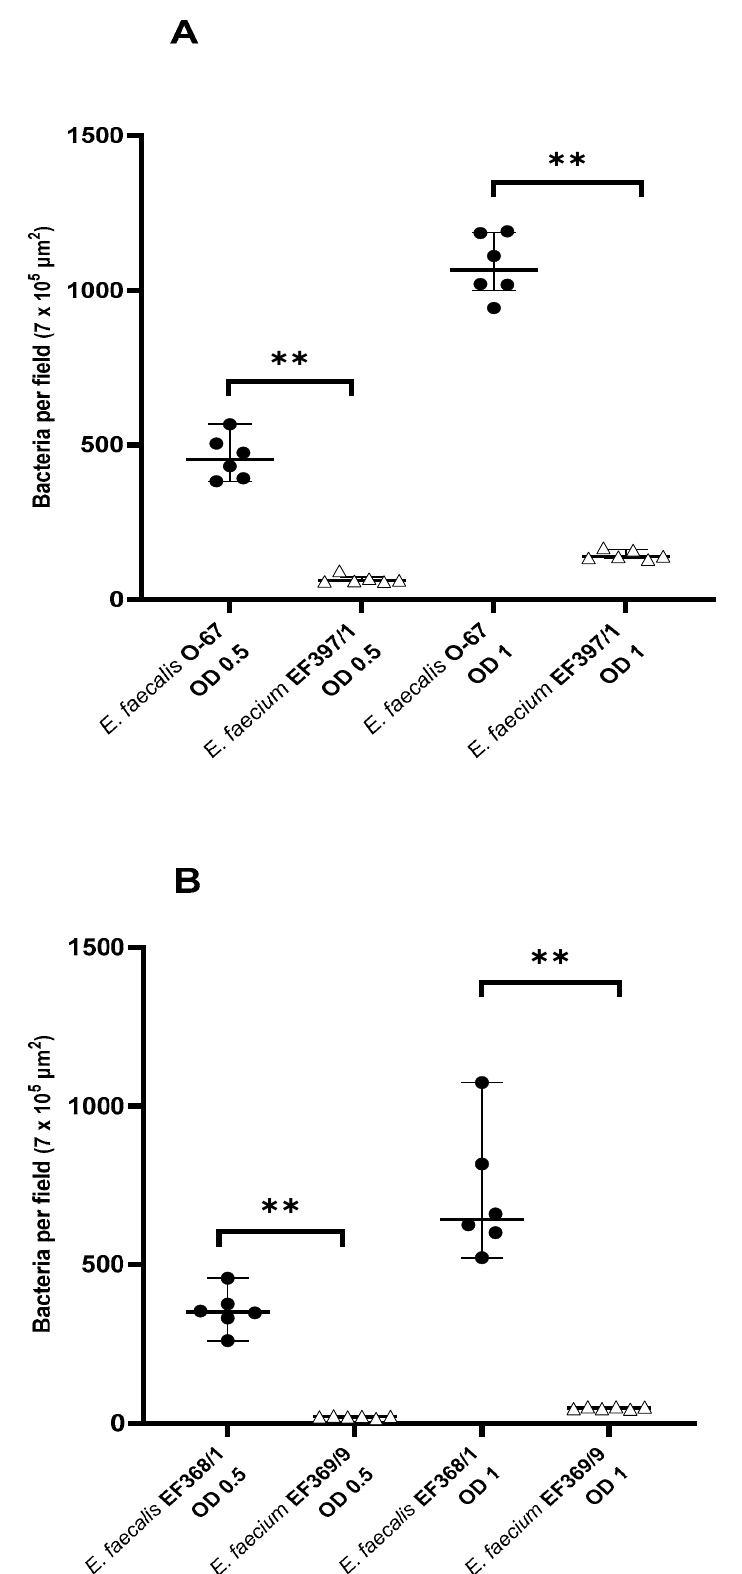
Figure 2. Scatter plot displaying the adherence of canine ( A ) and chicken ( B ) E. faecalis and E. faecium to the duodenal mucosa of healthy beagles. Data are expressed as the median with range. OD, optical density at 600 nm; ** p < 0.01.